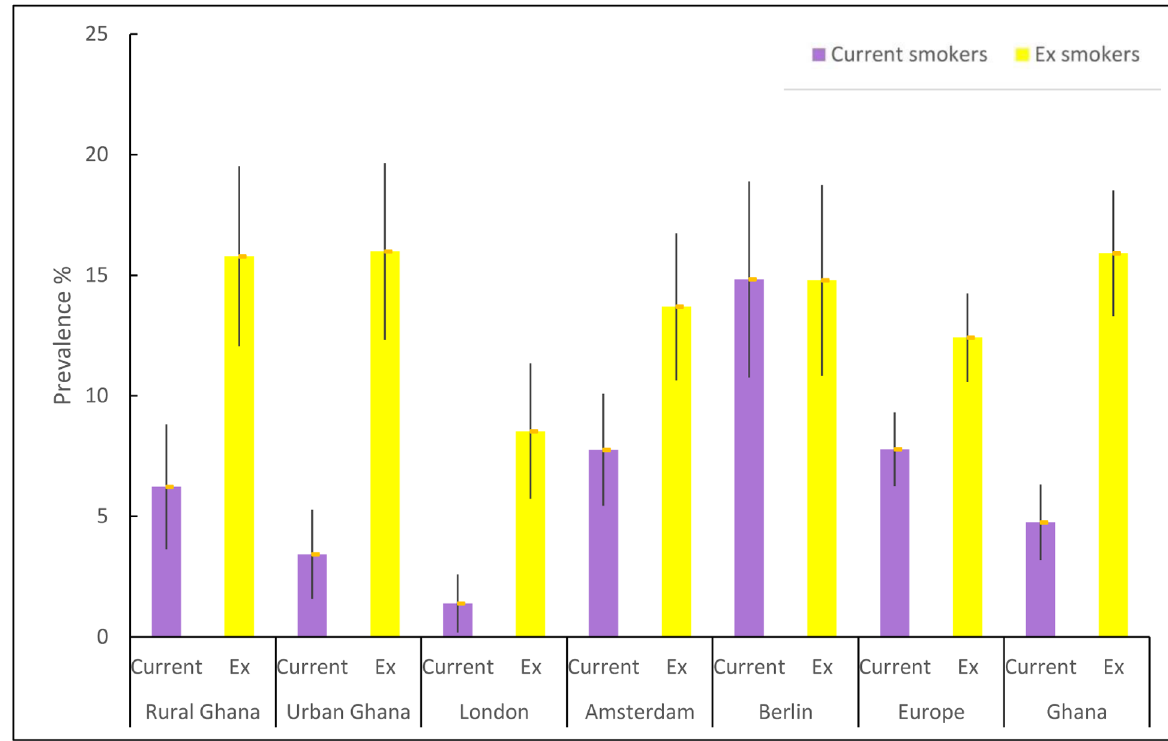
Fig 2. Age-standardized prevalenceof current and ex-smokers among